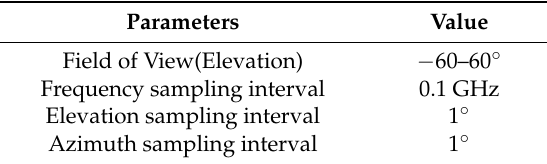
Table 2. System parameters of the metamaterial aperture antenna.